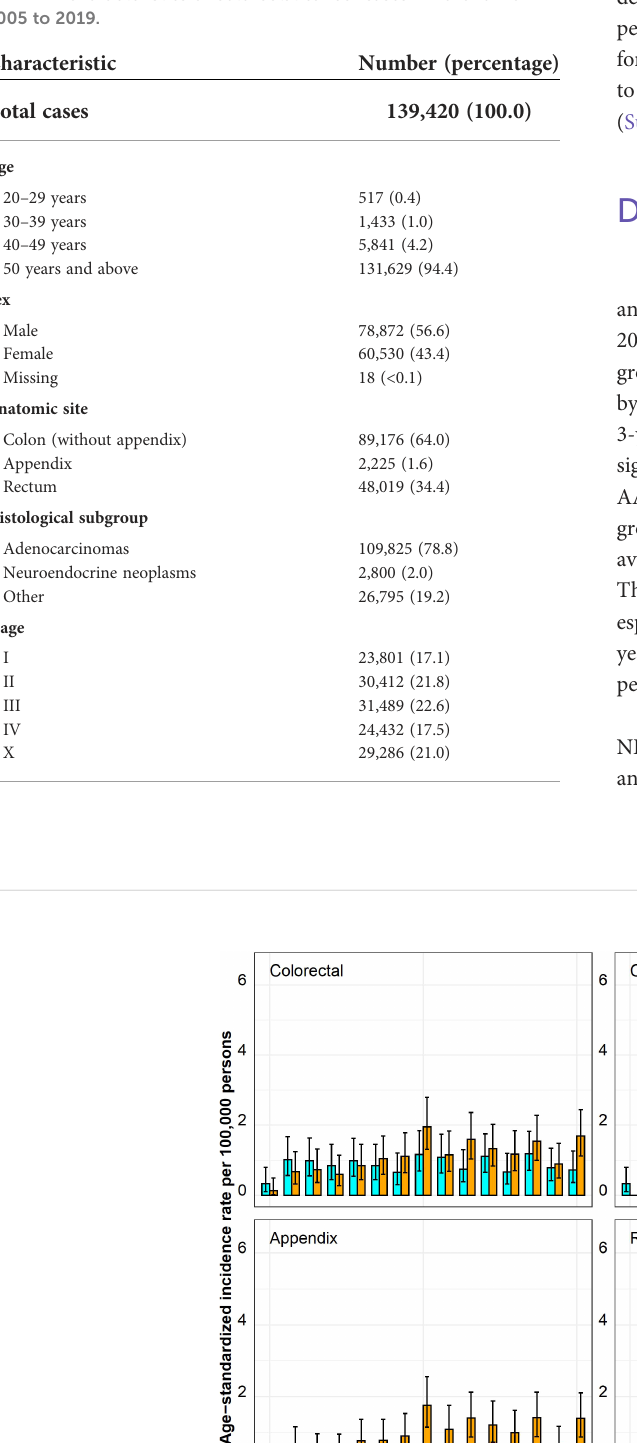
TABLE 1 Characteristics of colorectal cancer cases in Bavaria from 2005 to 2019.